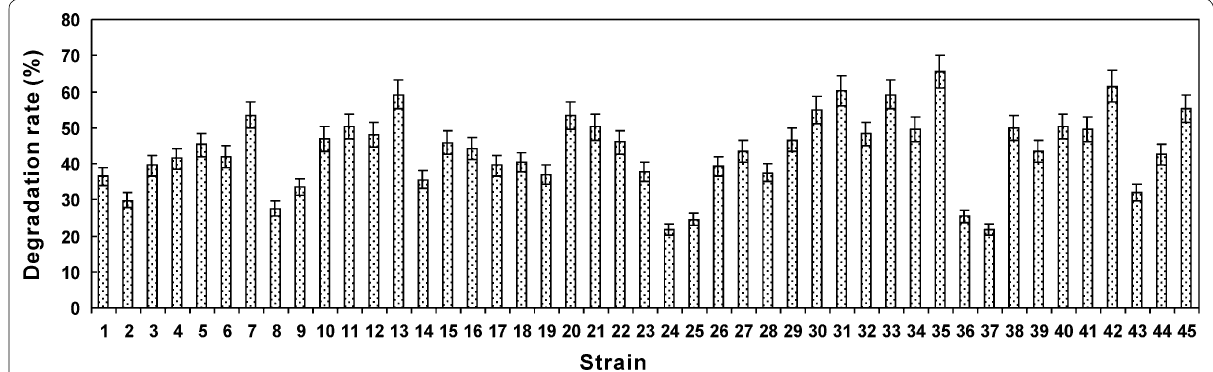
Fig. 2 Strains with the NH 4 + ‑N‑degrading ability. The degradation rates were detected after incubation for 2 days. The detections were performed in triplicate, and the results were presented as mean standard ±